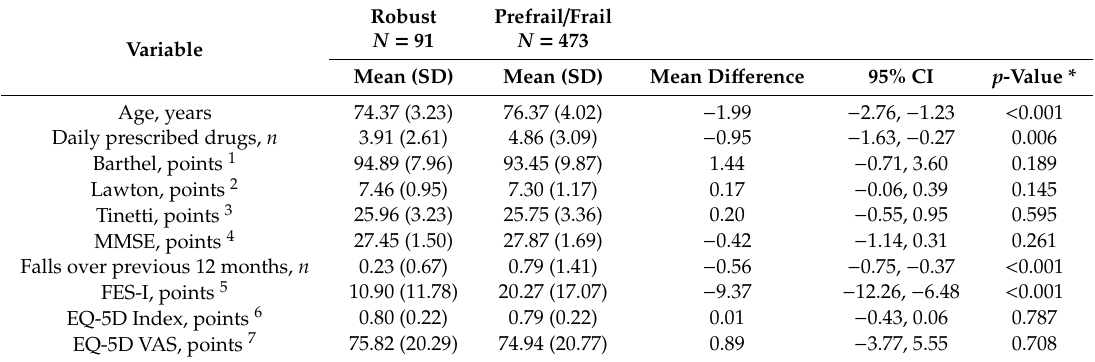
Table 2. Age, functional, and cognitive characteristics in robust versus prefrail / frail participants.